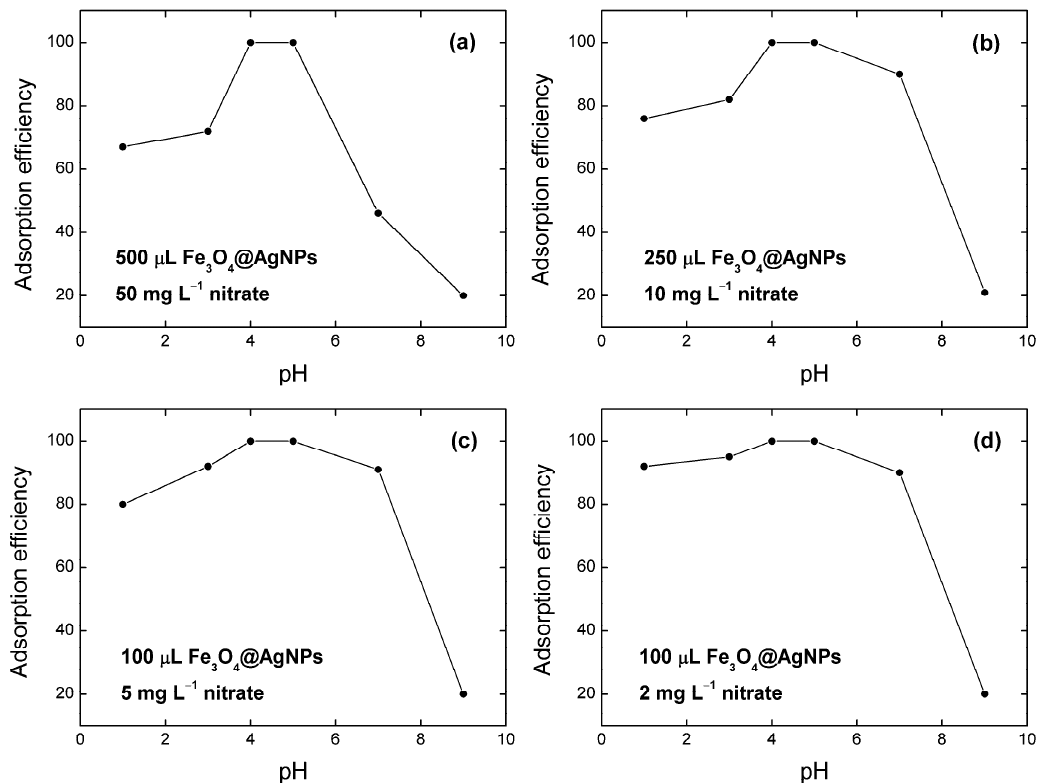
Figure 5. Dependence of the adsorption efficiency on pH for different volumes of Fe 3 O 4 @AgNPs and nitrate concentrations, respectively: ( a ) 500 µ L and 50 mg L − 1 , ( b ) 250 µ L and 10 mg L − 1 , ( c ) 100 µ L and 5 mg L − 1 , and ( d ) 100 µ L and 20 mg L − 1 . Screening of electrostatic interactions becomes greater as nitrate concentration increases.